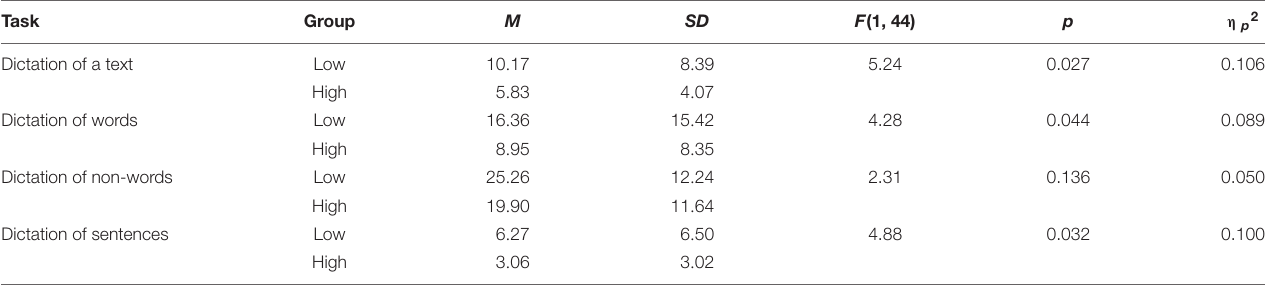
TABLE 2 | Descriptive statistics and results of the univariate tests comparing the two groups on the orthographic tests.